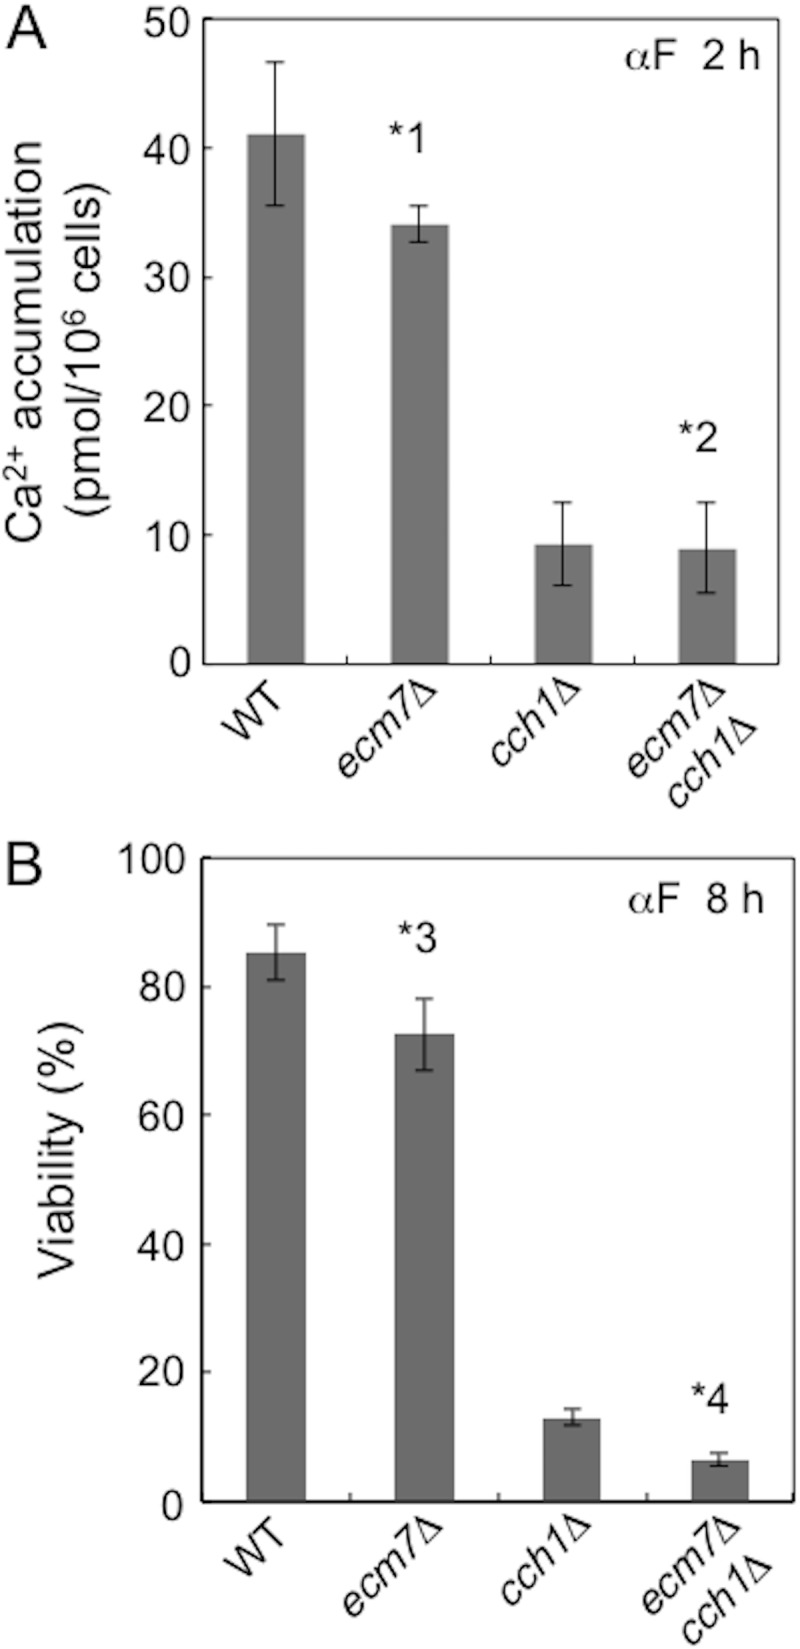
The deletion of ECM7 results in a slight decrease in Ca2+ accumulation and viability in CNB1+ cells.Cells grown in SD.Ca100 medium were treated with 6 μM α-factor and incubated. Ca2+ accumulation and the viability of cells were assessed 2 h and 8 h after the addition of α-factor. *1, p < 0.05 (WT vs. ecm7Δ); *2, p > 0.05 (cch1Δ vs. cch1Δ ecm7Δ); *3, p < 0.05 (WT vs. ecm7Δ); *4, p < 0.05 (cch1Δ vs. cch1Δ ecm7Δ). Data are the mean ± SD of three independent experiments.